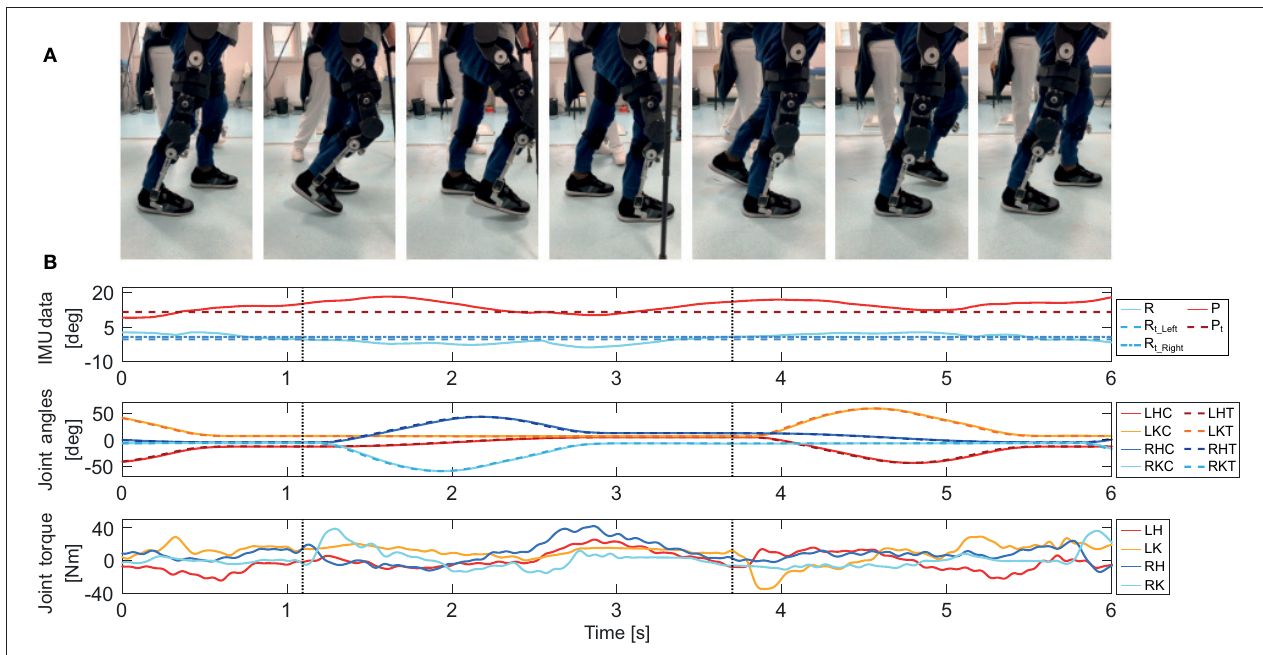
FIGURE 10 | (A) Walking sequence of the SCI subject performing straight walk in controlled environment. (B) (Top) Roll and pitch angles as recorded from the IMU, and corresponding thresholds, (Middle) reference and recorded angular joint positions, (Bottom) torques delivered by the joints. The dotted vertical lines denote the step trigger. A pause of 0.15s between the trigger detection and the actuation of the motors was intently set to signal the patient a step was about to be